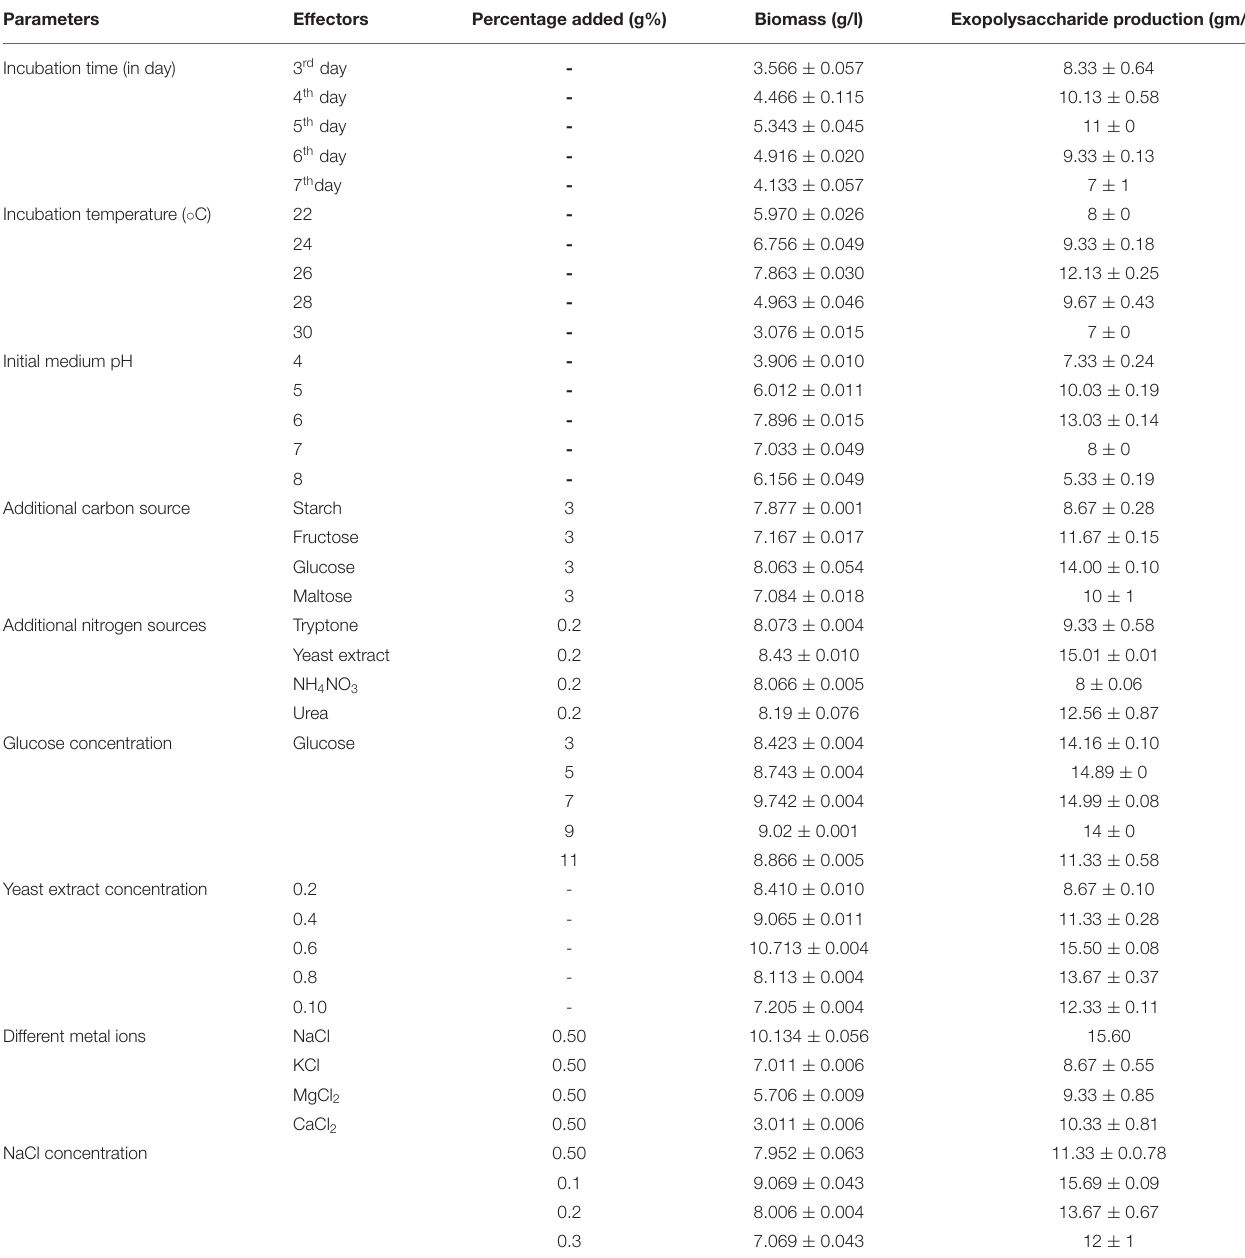
TABLE 1 | Effect of various physical parameters and chemical supplements on biomass and exopolysaccharide (EPS) production by Colletotrichum alatae